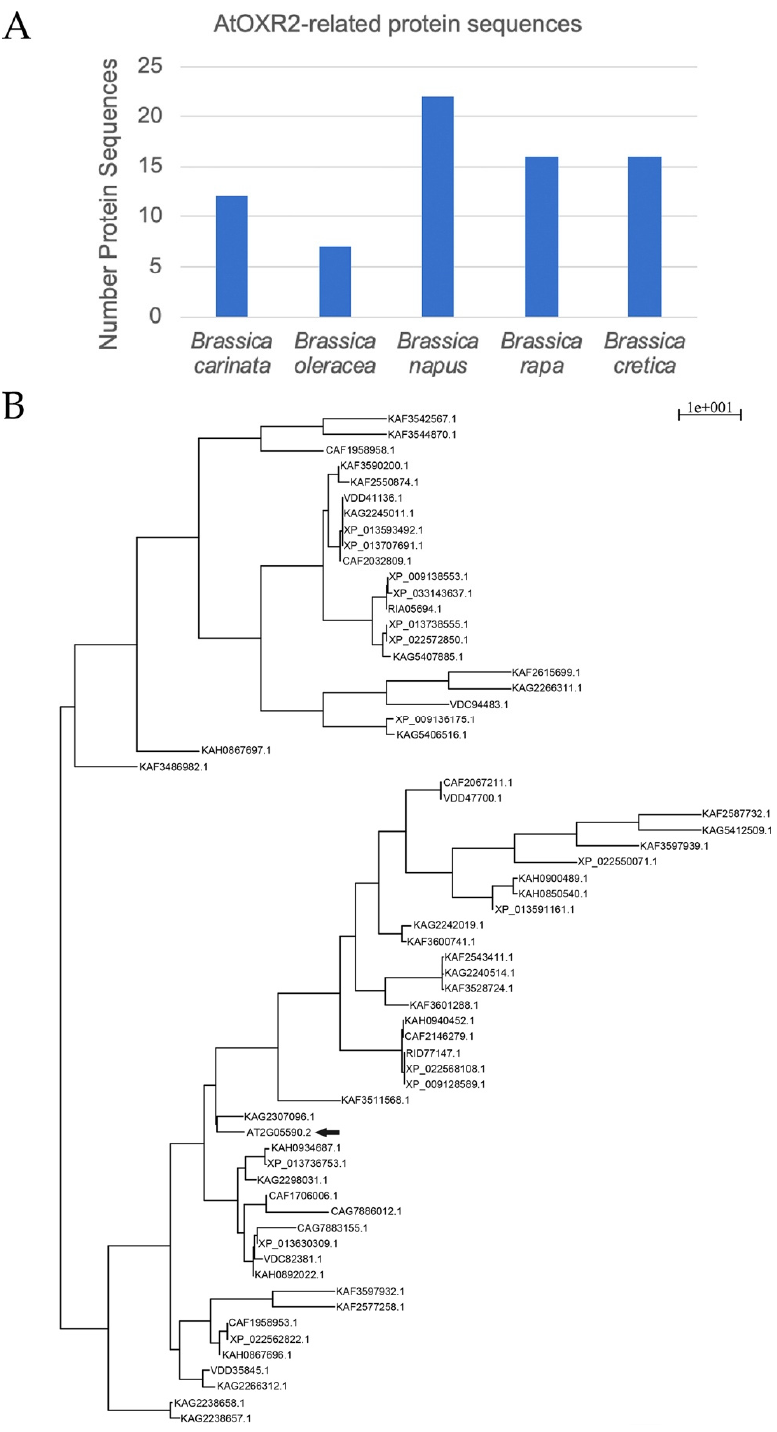
Figure 7. ( A ) Analysis of the AtOXR2 (AT2G05590) homologs in Brassica species. The number of AtOXR2-related proteins distributed in the different species identified from the Brassica database (http://brassicadb.cn/#/, accessed on 17 October 2021) and the Blastp tool [46,47]. Sixty six homologous sequences from B. oleracea (taxid:3712), B. napus (taxid:3708), B. rapa (taxid:3711), B. cretica (taxid:69181), and B. carinata (taxid:52824) were used for the analysis. ( B ) Phylogenetic tree showing the relationship of AtOXR2 to the other Brassica species, obtained using the Seaview 4.5.0 software and the PhyML-aLRT-SH-LIKE algorithm [48] with maximum likelihood tree reconstruction. See Figure S3 for the sequence alignment of proteins used to build this comparison tree.